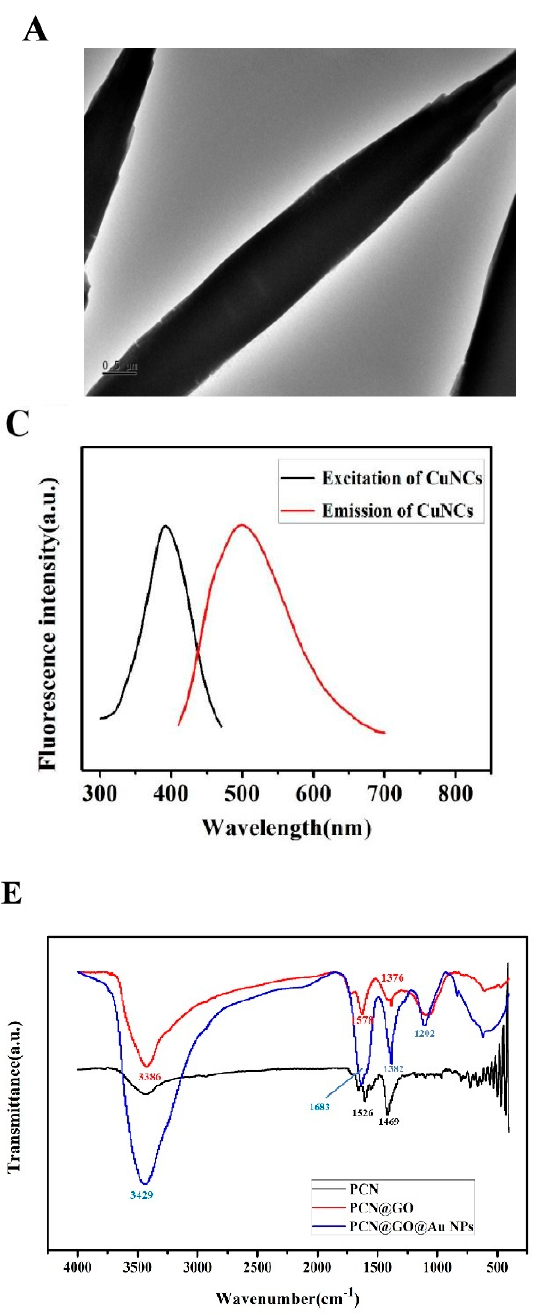
Figure 2. ( A ) PCN nanomaterial and TEM. ( B ) PCN@GO@AuNP composite nanomaterial and TEM. ( C ) Fluorescence excitation and emission spectra of CuNCs. ( D ) PCN@AuNP composite nanomaterial. ( E ) The peaks of hydroxy O-H were 3386 and 1376 cm − 1 , and 1578 cm − 1 was the absorption peak of epoxy C-O. These were the characteristics of GO. After AuNPs were added, the peak moved; it showed that AuNPs bound to the surface of PCN@GO in the complex.